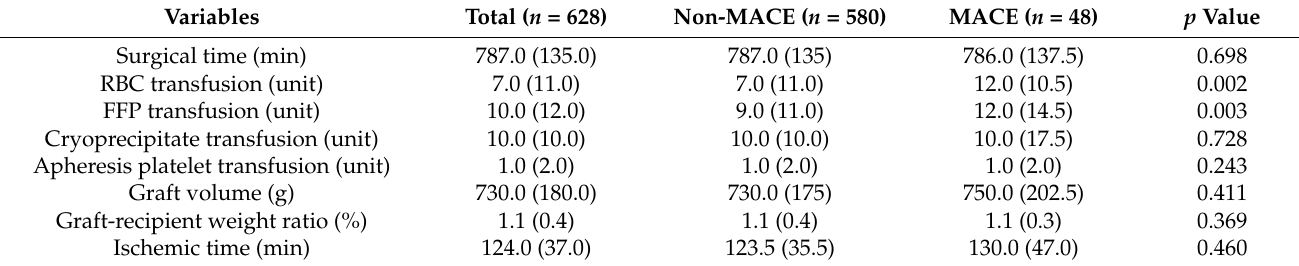
Table 3. Intraoperative variables of liver transplant recipients according to the major adverse cardiac events that developed.